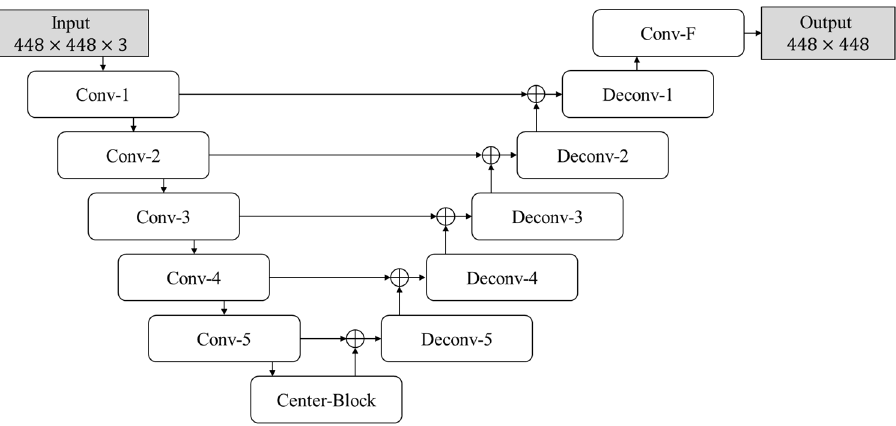
Figure 6. Simple architecture of the employed U-Net-based model. Table 1. Complete composition of the employed U-Net-based model.